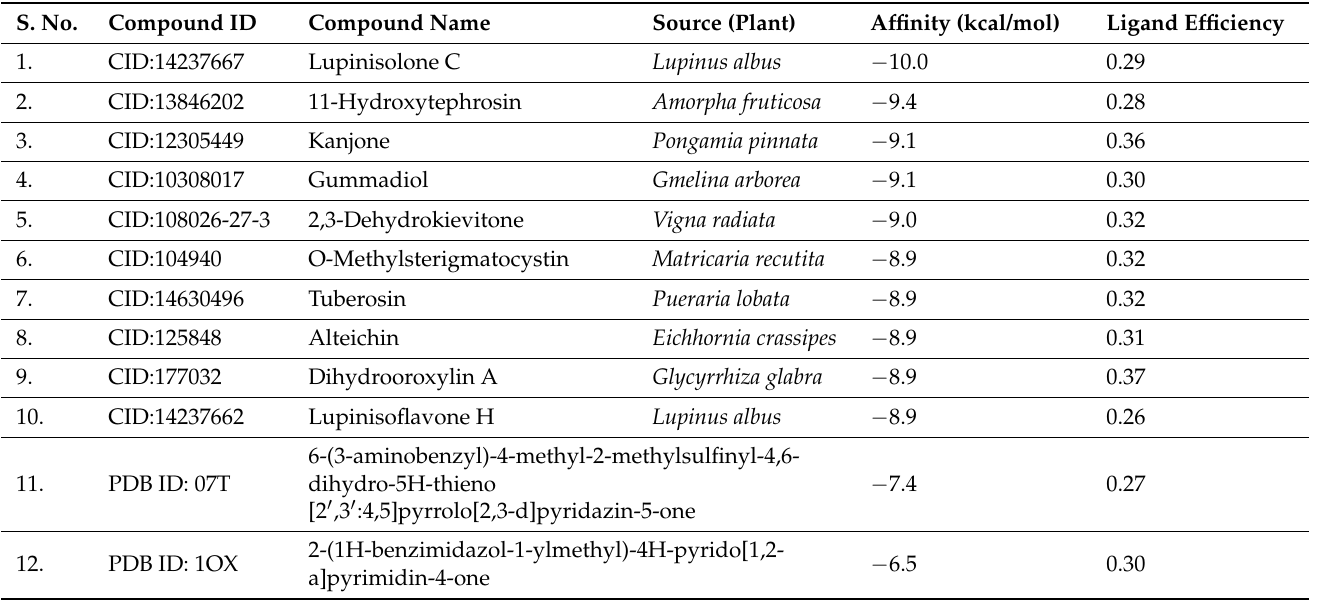
Table 1. Selected hits, their source and binding affinities, and their ligand efficiency toward PKM2. Two compounds (PDB IDs: 07T and 1OX were taken as references for docking score comparison).